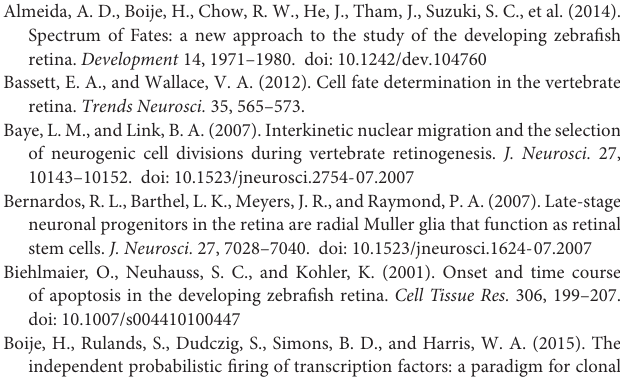
Arrowheads indicate neurite in the IPL. Scalebar, 5 µ m. Supplementary Figure 3 | Expression of thrb:Tomato is negligible in the GCL. Line graphs displaying the number of PCNA, thrb:Tomato and PCNA and thrb:tomato -double positive cells in the GCL of light-damaged Tg[thrb:tomato]q22 zebrafish retinas. Mean ± SE, n ≥ 9. Supplementary Figure 4 | Damage paradigms differentially affect inner retinal neuron survival. (A–D) Histograms displaying the number of HuC/D-positive cells in the INL (A,C) and GCL (B,D) following light-damage (A,B ; 0, 36, 48, 60, 72 hLT ) and metronidazole exposure of Tg[rho:Eco.nsfB-EGFP]nt19 zebrafish (C,D ; 0, 48, 72, 96 h post mto ) . E) TUNEL-positive cells in the undamaged retina and at 36 h after NMDA exposure in the rod and cone nuclear layers, the apical and basal INL and the GCL. (F–H) Histograms displaying the number of HuC/D-positive cells in the GCL (F) and INL (G) and the number of Zpr-1-positive cells (H) in NMDA-damaged retinas. Mean ± SE, n > 8. p t − test < 0.05 in E ,